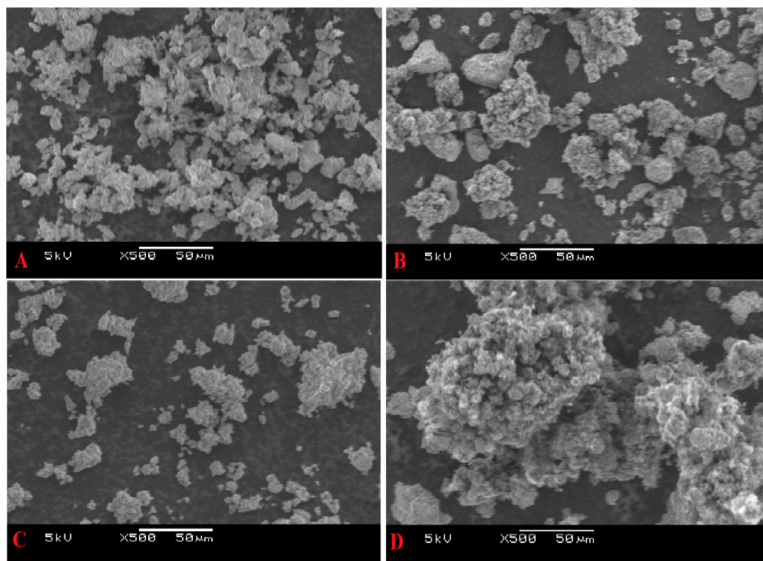
Figure 8. Scanning Electron Microscope (SEM) images for ( A ) fresh 5%Ni / Al 2 O 3 (SA-5239), ( B ) used 5%Ni / Al 2 O 3 (SA-5239), ( C ) fresh 5%Ni / Al 2 O 3 (SA-6175), and ( D ) used 5%Ni / Al 2 O 3